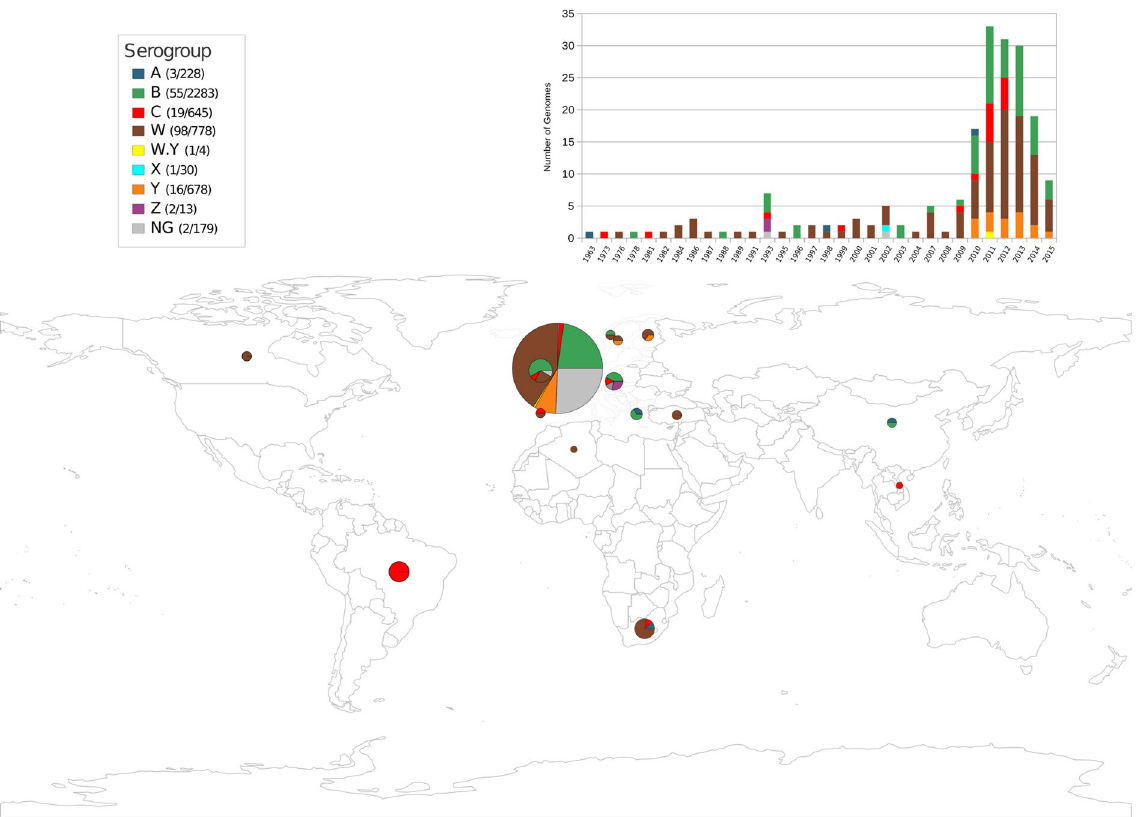
Figure 4. ICE Nm CC103 geographical distribution and its abundance among N. meningitidis genomes from distinct serogroups. This figure has been created in R 51 using the Rworldmap package 52 . The legend on the top left side shows the number of genomes positive for ICE Nm CC103 element relative to the total number of genomes of each serogroup. On the top right the prevalence of this element in genomes is shown for different serogroups (different colored bar sections) and year of